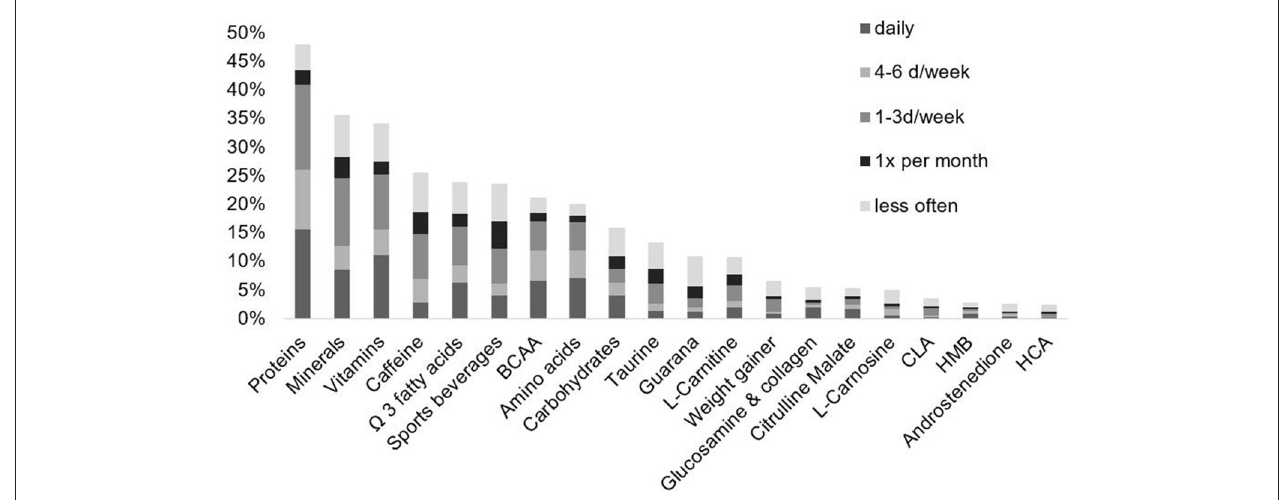
FIGURE 1 | Prevalence and frequency of NS consumption of 492 fitness center